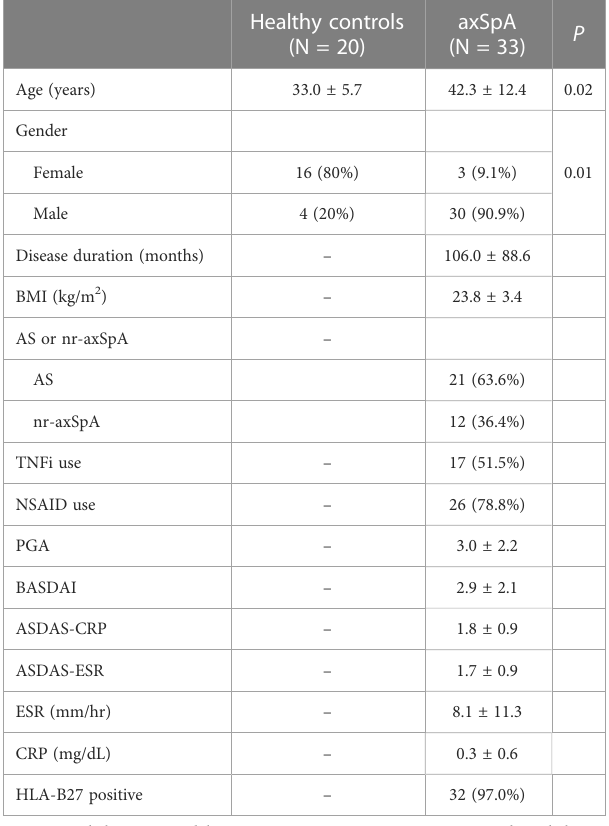
TABLE 1 Patient demographics and disease related